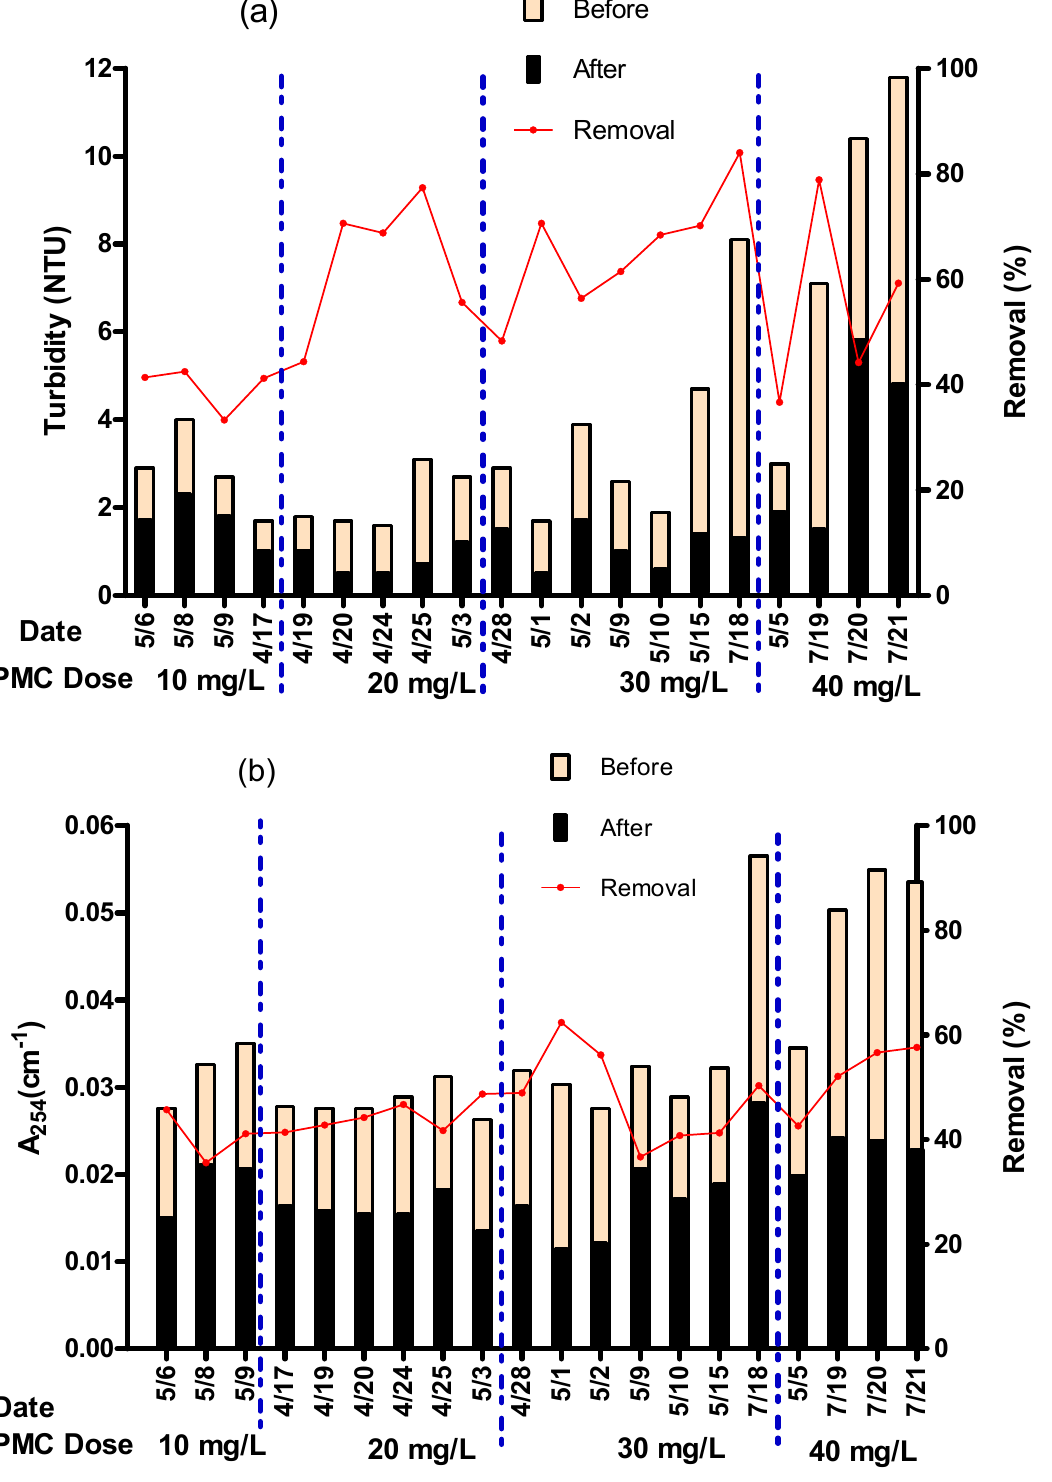
Figure 9. Removal of turbidity ( a ) and UV 254 ( b ) with varying doses of the PMC-based coagulant in the pilot-scale tests (10, 20, 30, and 40 mg/L).